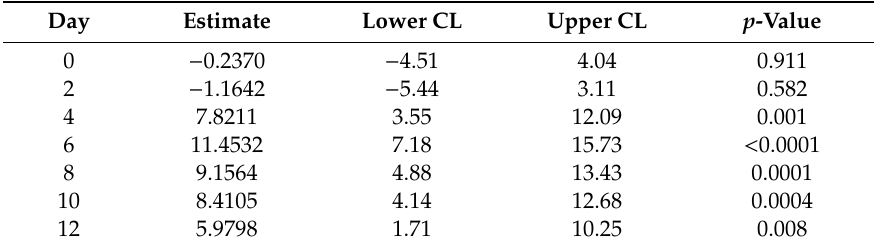
Table 4. Di ff erence between 0-dose and high-dose groups in least square means of NES RNA expression according to